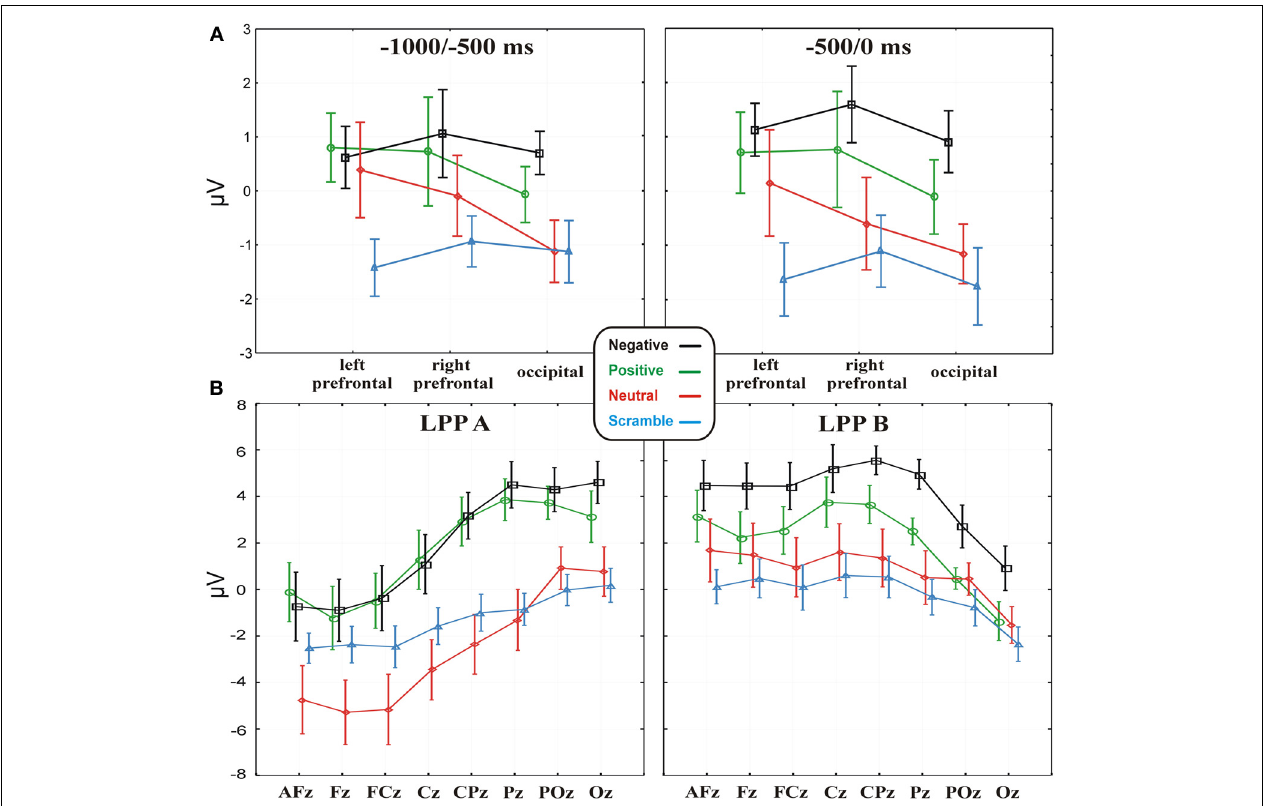
FIGURE 4 | (A) Data (values are the mean ± s.e.m.) of the MRCP activities in the four emotional conditions, separately for the − 1000 to − 500 and − 500 to 0 time windows on the three electrode